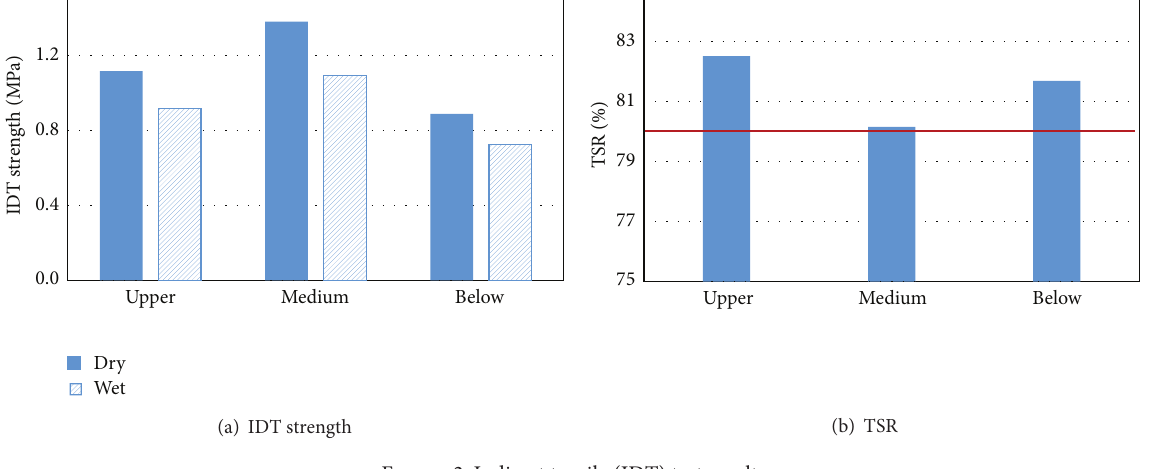
Figure 2: Indirect tensile (IDT) test result.